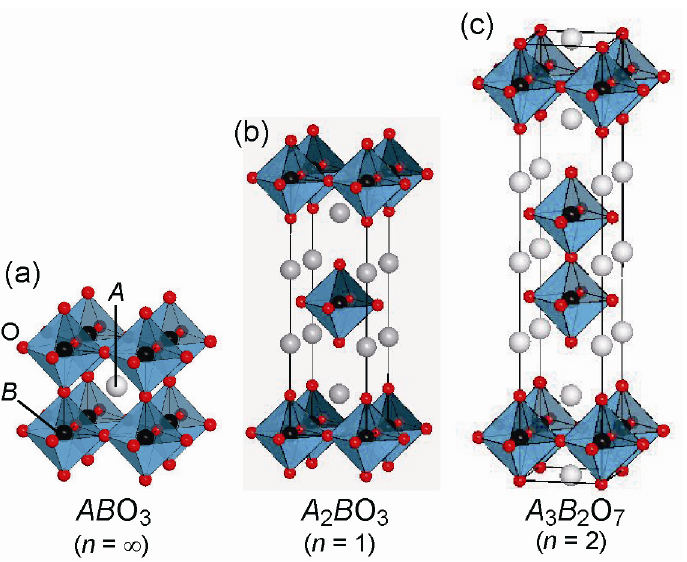
B O ( n = 1, 2, ∞ n − 1 n 3 n +1